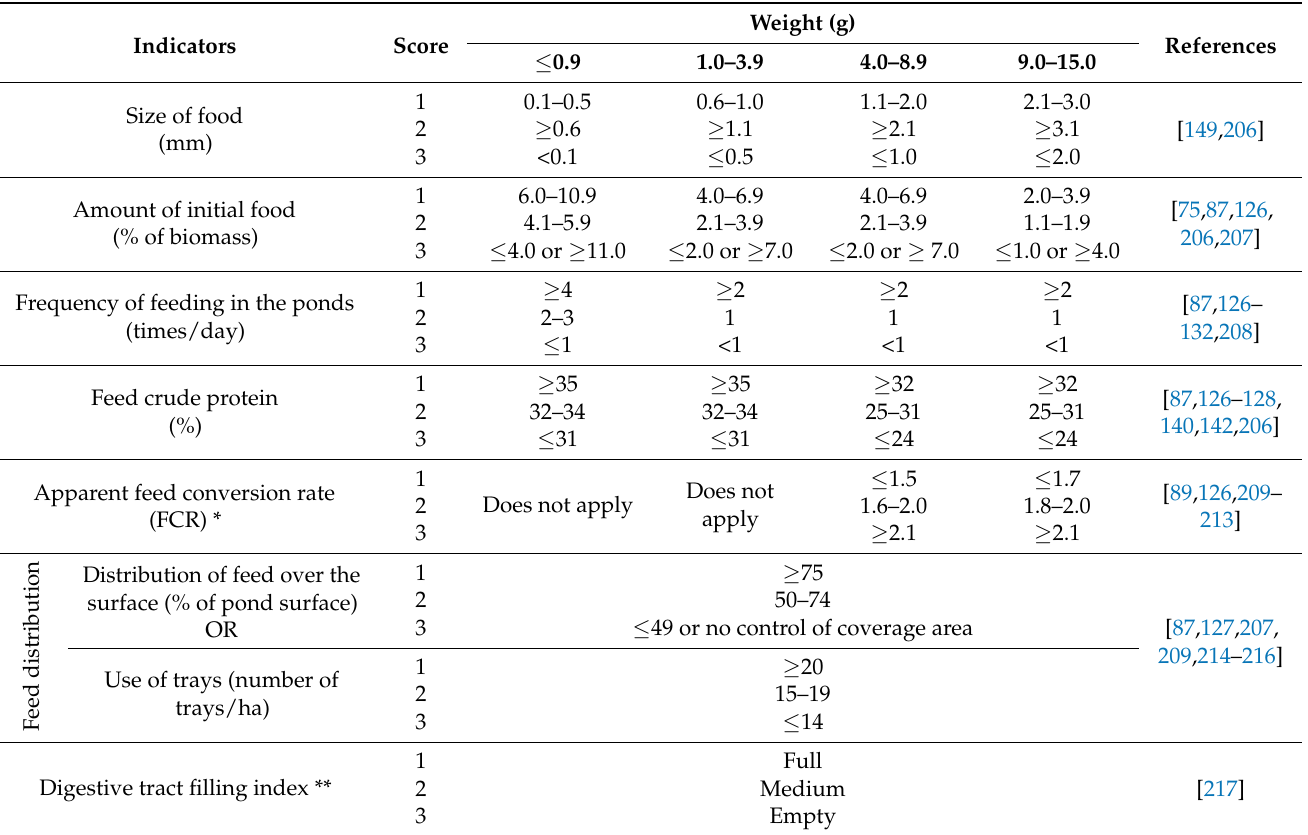
Table 13. Nutritional indicators for Penaeus vannamei juveniles and adults.